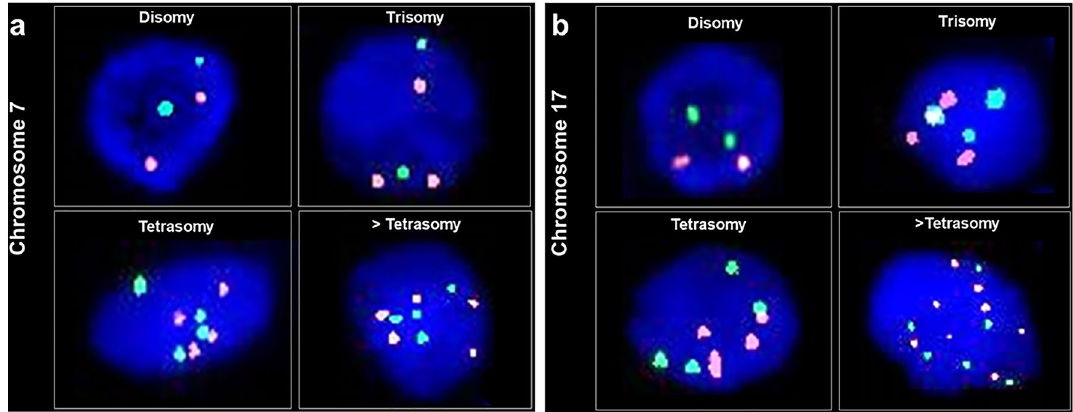
Figure 1. Representative FISH image ( a , b ). The pattern of chromosome 7 and 17 copy numbers including disomy (2 signals), trisomy (3 signals), tetrasomy (4 signals) and > tetrasomy (> 4 signals). Probes: CEP7; red, CEP17;